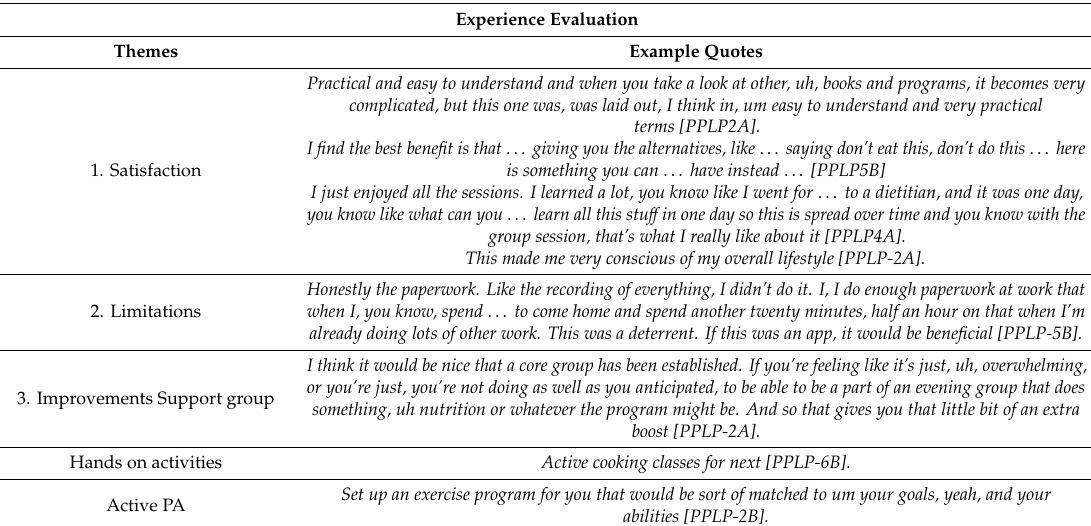
Table 6. Qualitative analysis, representative quotes for key program evaluation